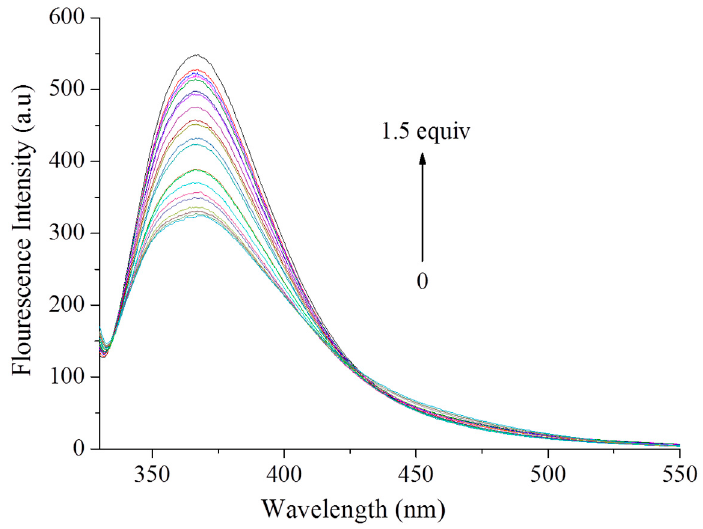
Figure 4. Fluorescence spectra of HL and its Ni(II) complex in ethanol upon excitation at 315 nm.